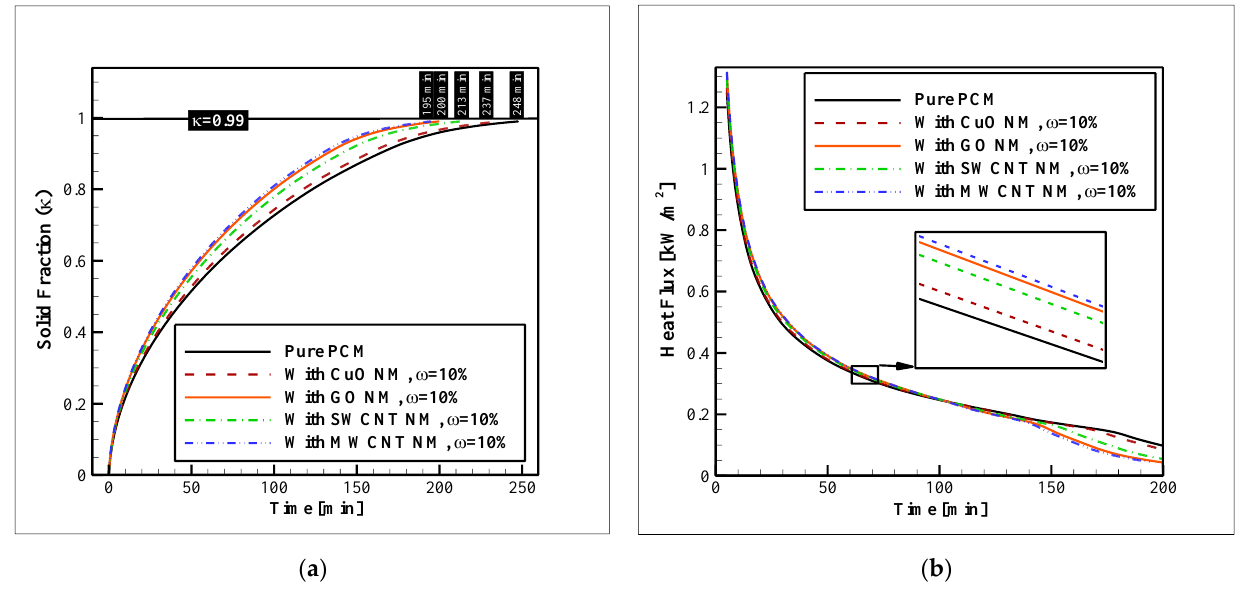
Figure 9. The influence of NM type at identical NM mass fractions on ( a ) progression of the average solid fraction; and ( b ) the heat flux passing through the refrigerant tubes.